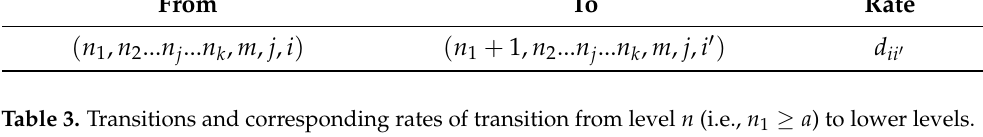
Table 2. Transitions and corresponding rates of transition from level 0 to 1. From